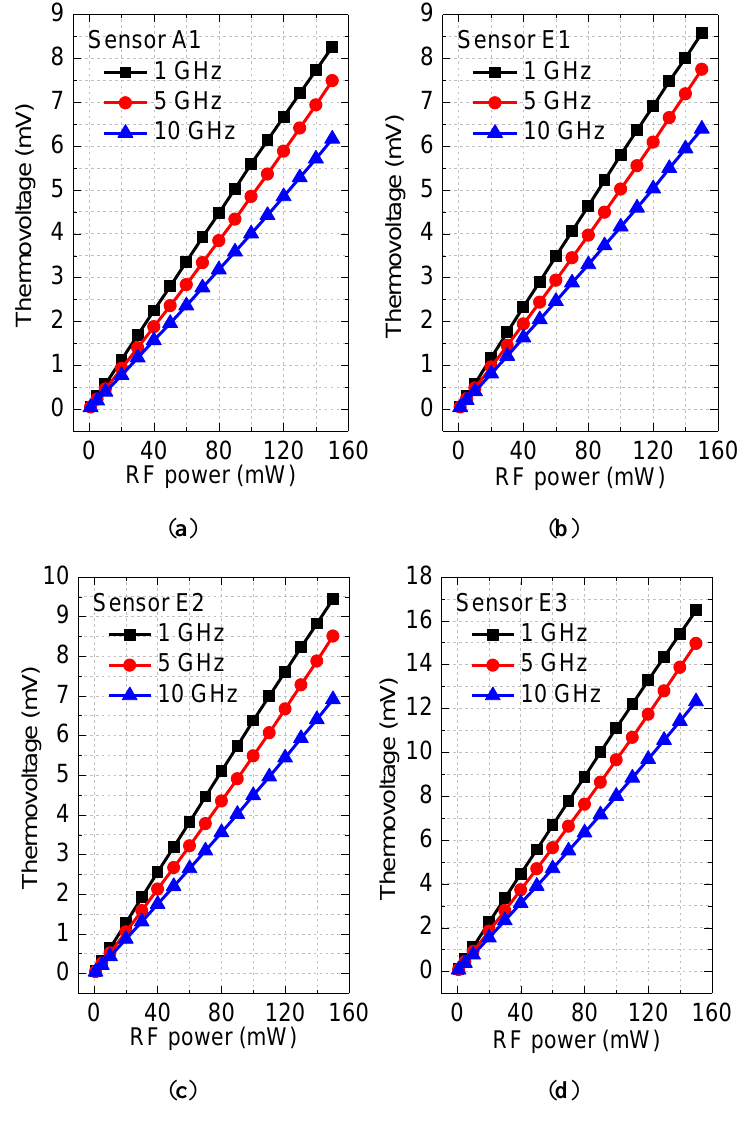
Figure 4. Measured output thermovoltages with respect to input RF power at 1, 5, and 10 GHz of these RF power sensors. ( a ) The sensor A1, ( b ) the sensor E1, ( c ) the sensor E2, and ( d ) the sensor E3.